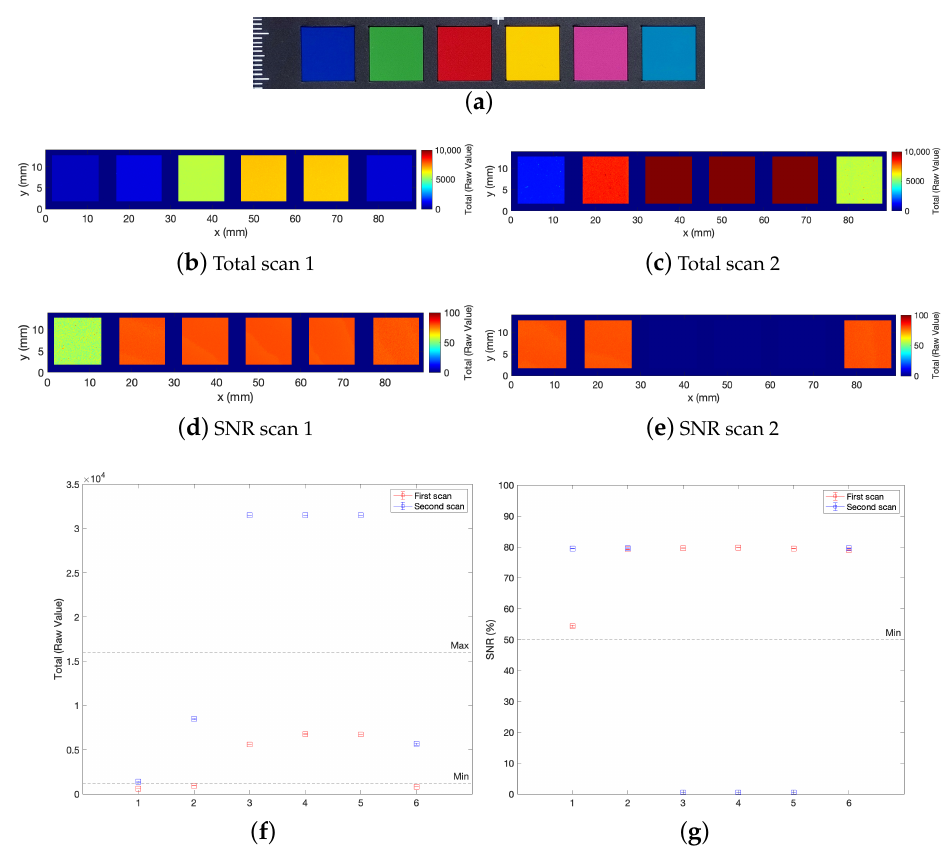
Figure 4. Feasibility test on a colorchecker. ( a ) Visible image of the acquired ROI. ( b , c ) Map of the Total values obtained with two optimized power settings. ( d , e ) Map of the SNR obtained with two optimized power settings. ( f , g ) Value of the Total (left) and of the SNR (right) averaged over the single color patch, with the acceptance threshold indicated; the x-label indicates the column in the colorchecker. Profilometer setup: 50 mm lens, 25µm scan step, 10mm/s scan